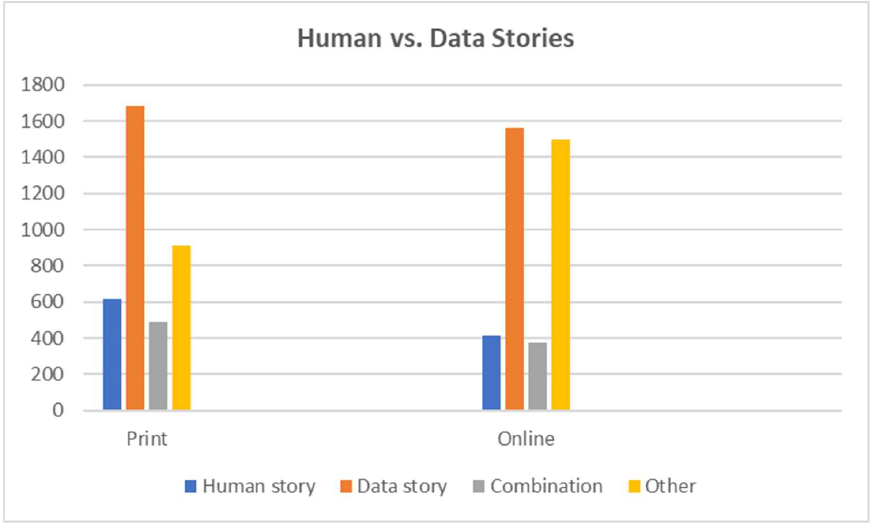
Figure 8. Human vs. Data stories. Table 6. Official media accounts by number of retweets.